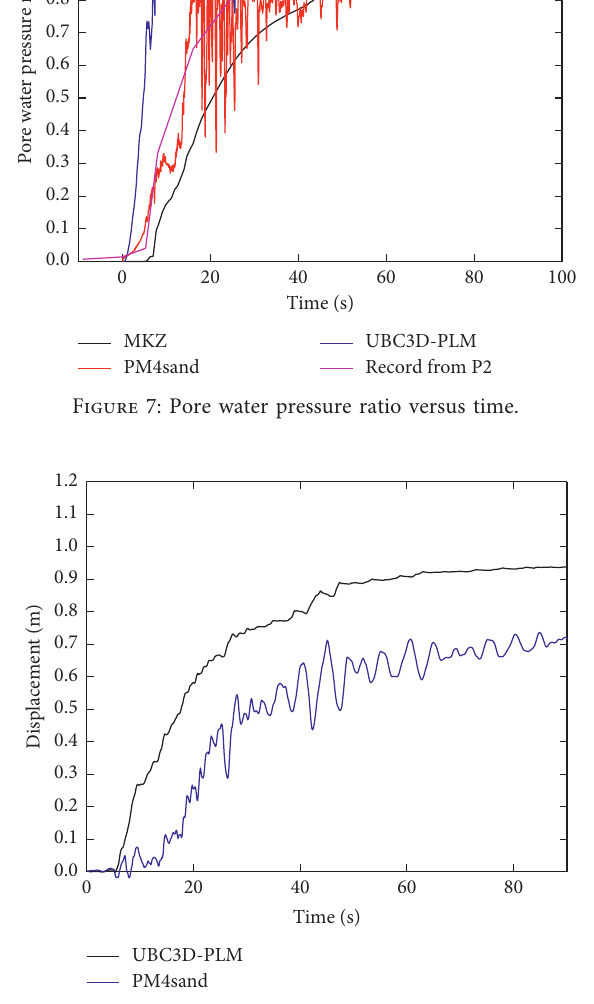
Figure 8: Lateral spreading versus dynamic